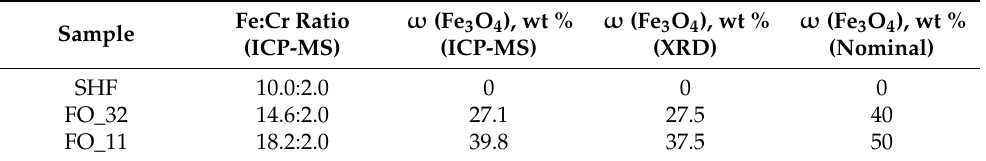
Table 1. Magnetite content ω determined by chemical analysis of the samples (ICP-MS) and by the Rietveld refinement of diffraction patterns. Chemical composition is normalized to (Fe + Cr) = 12 for the initial hexaferrite sample.